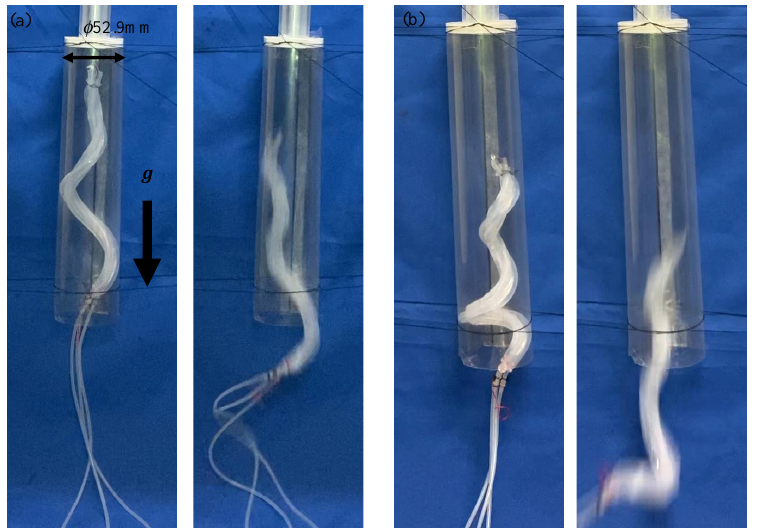
Figure 16. Experiment using a biased pitch device in a vertically fixed pipe with the same di- ameter as that of the 50A. ( a , b ) depict the device driven by an air pressure of 0.14 MPa and 0.18 MPa, respectively.